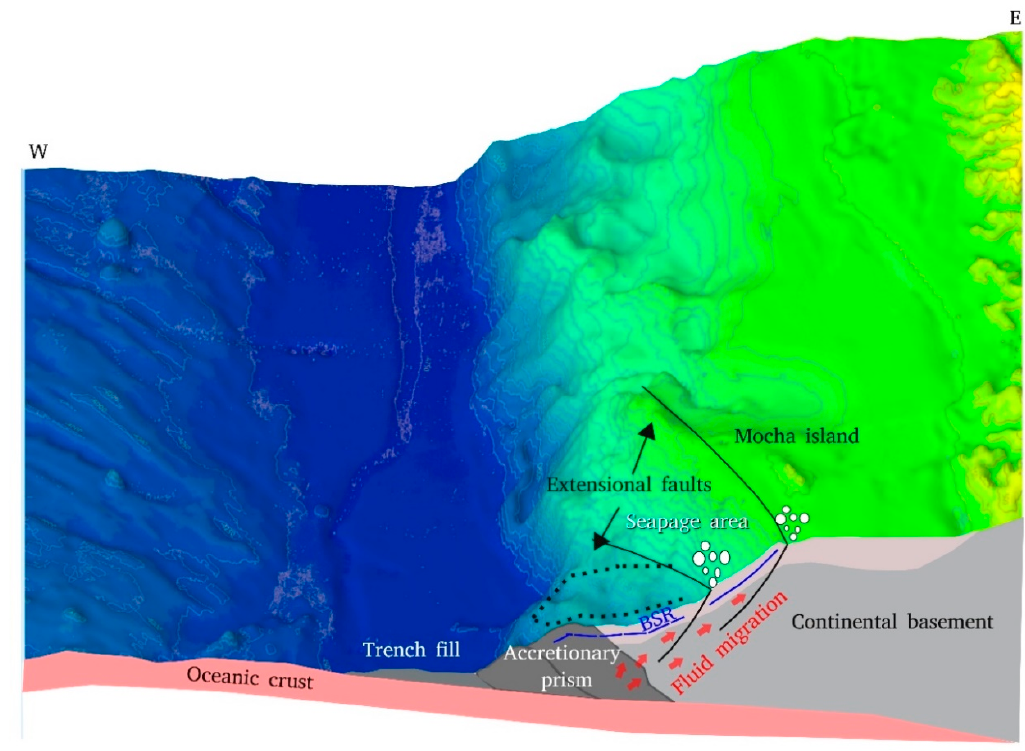
Figure 5. Schematic diagram of SO161–35 seismic profile located close to 38°30 ′ S (see Figure 1), explaining fluid migration processes close to the Mocha Island. Faults are reported by Berndt et al. [17], Horozal et al. [18]. Dashed line shows part of the ancient sliding reported by Geersen et al. [60].